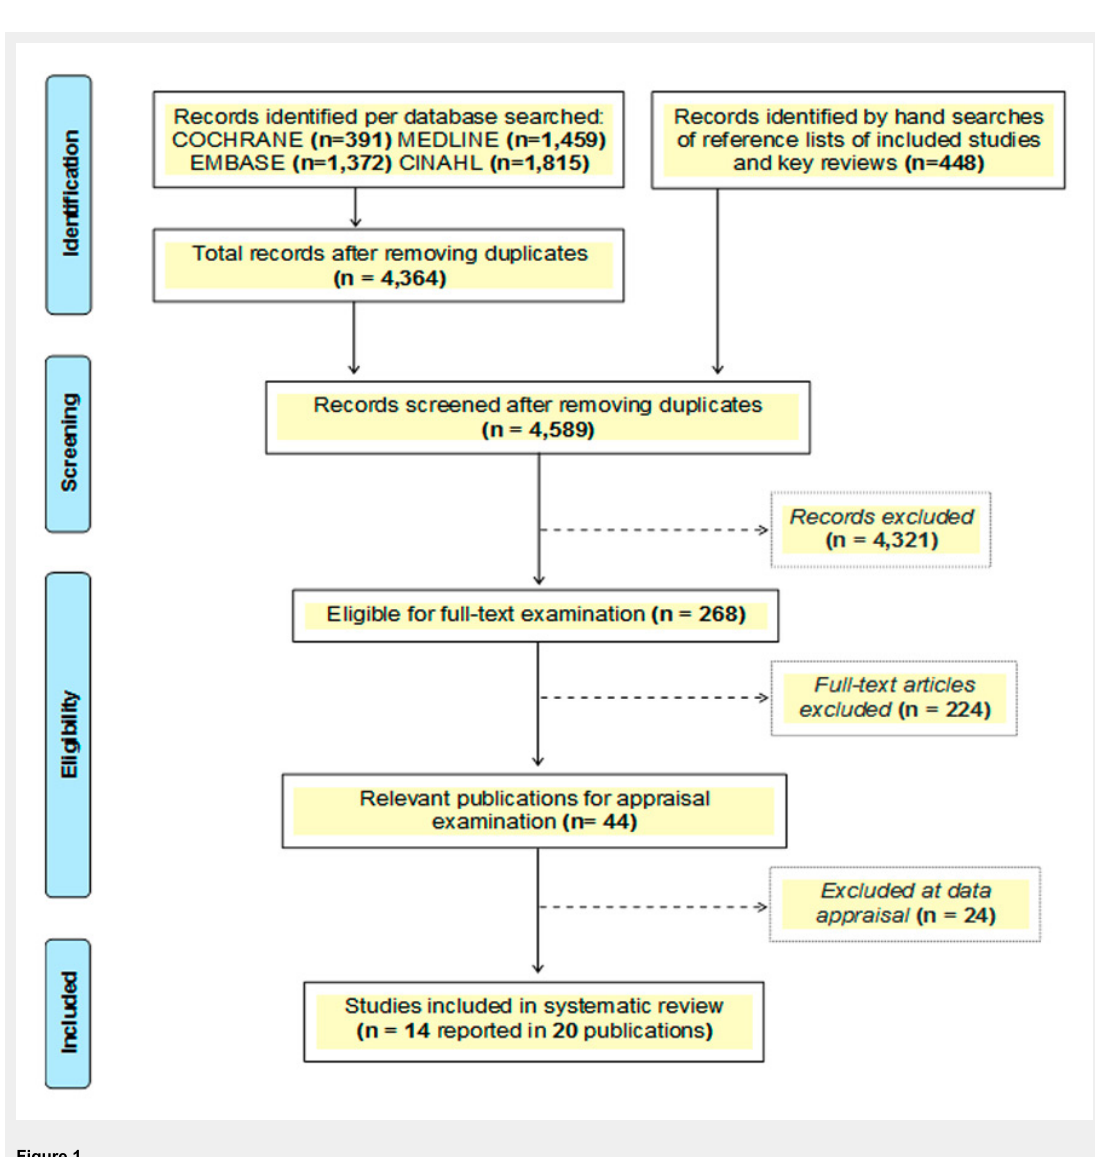
Flow diagram – study selection